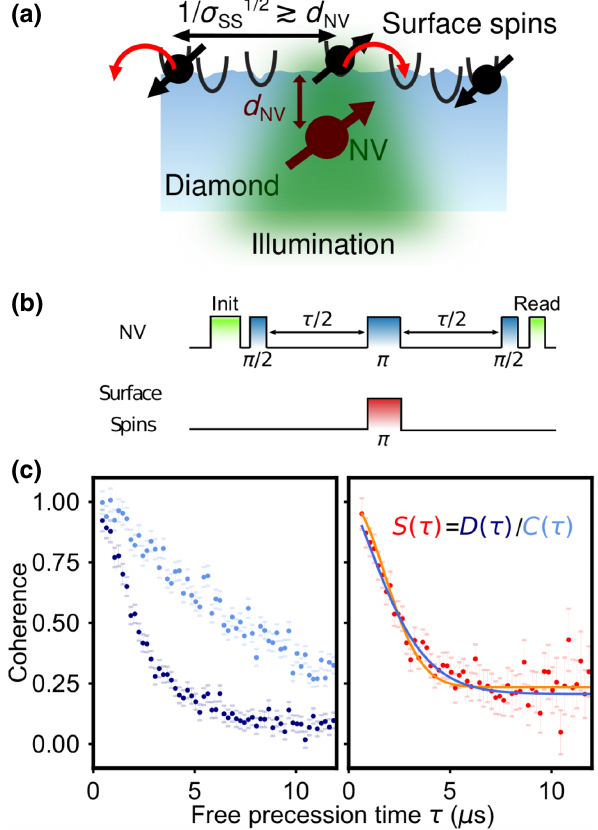
FIG. 1. Double electron-electron resonance of diamond sur- face spins. (a) Sketch of the experiment, depicting a near surface NV center (dark red arrow) with nearby traps (black wells) that are transiently occupied by spin 1/2 defects (black arrows). A 532-nm laser is used to polarize and readout the NV center. (b) Pulse sequence for DEER, where simultaneous microwave π pulses are applied to the NV center (blue block) and surface spins (red block) midway through the free precession interval τ . Green blocks indicate NV center spin initialization and readout. (c) Spin echo, C (τ) (light blue), and DEER, D (τ) (dark blue), curves for a representative NV center with coherence oscillations caused by slight magnetic field misalignment (left panel). In order to investigate the DEER signal S (τ) (red) without the influence of decoherence from other sources, D (τ) is divided by the coher- ence curve C (τ) (right panel). The orange fit is constrained to a stretching factor n = 2, while n is a fit parameter for the blue curve. Error bars in (c) are the standard error of the mean due to photon shot noise, propagated point by point for the right